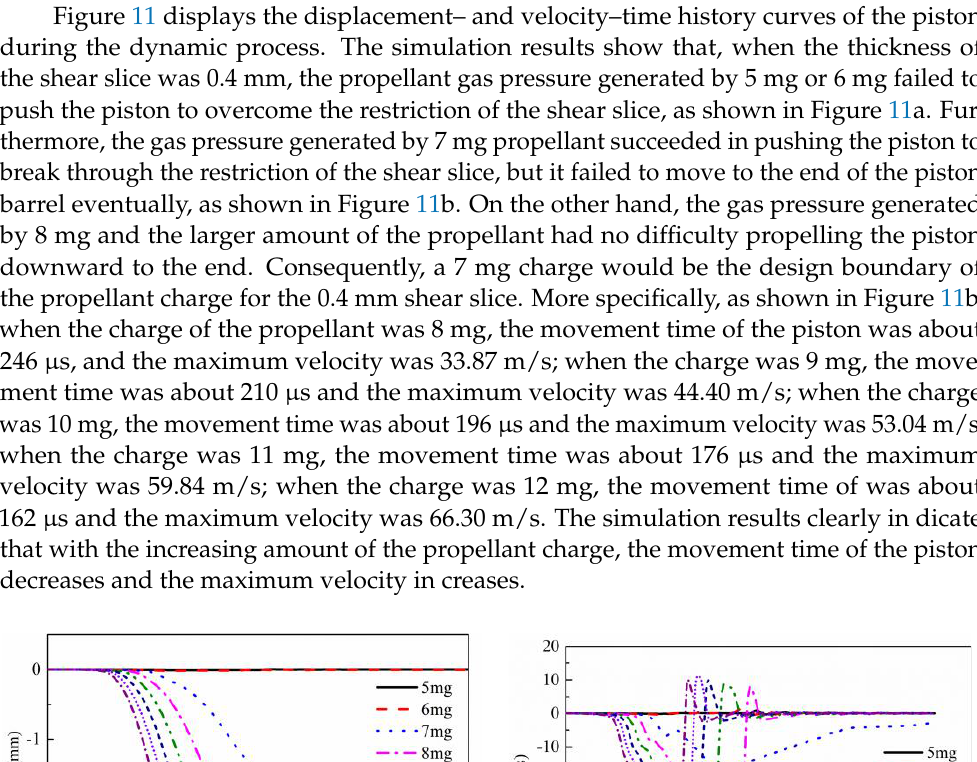
Figure 10. Movement process of the piston: ( a ) t = 0 μs ; ( b ) t = 64 μs ; ( c ) t = 128 μs ; ( d ) t = 200 μs ; ( e ) stress distribution of propellant actuator at a certain time.